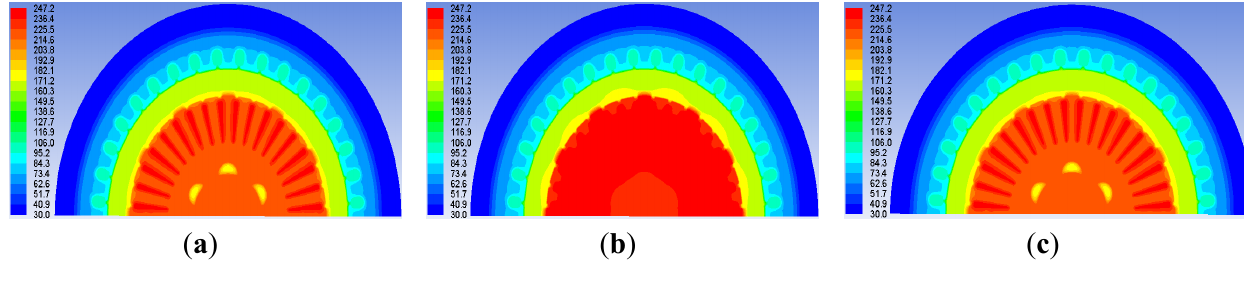
Figure 12. Thermal field distribution of three different cross-sections: ( a ) the water inlet side; ( b ) the middle cross-section; and ( c ) the water outlet side.